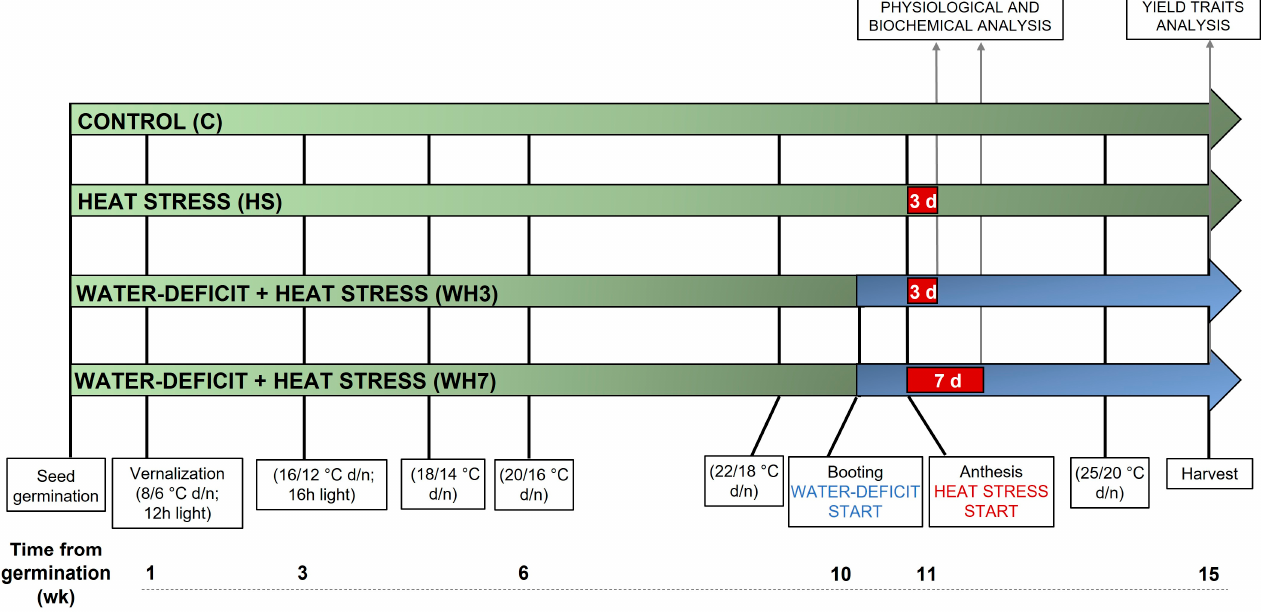
Figure 3. Timeline and features of experimental plant growth conditions, stress treatments application and data recording. Approximate duration (in weeks, wk) of main growth intervals and of the total cycle since seed germination is indicated. d = days.